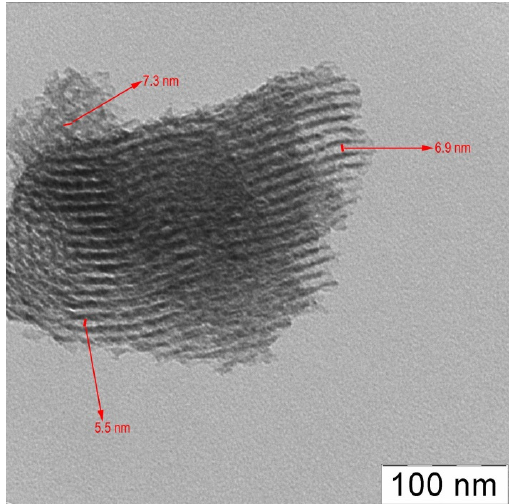
Figure 1. Transmission electron microscopy (TEM) microphotography of G2-dendr- meso -SiO 2 material.